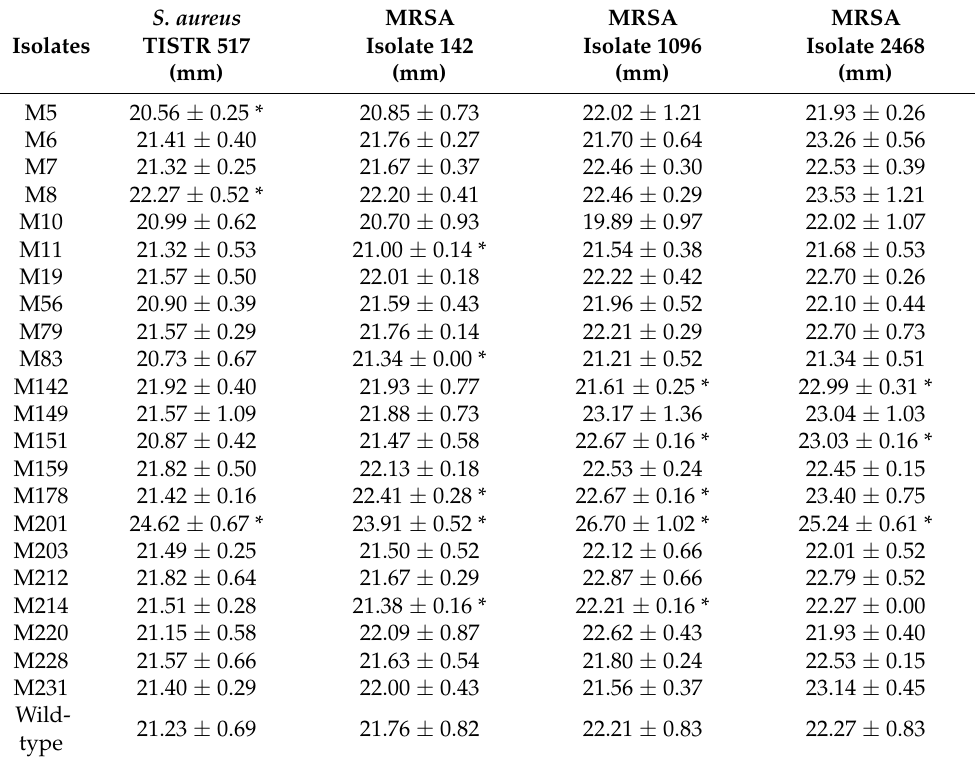
Table 4. Comparison of antibacterial activity between Brevibacillus sp. SPR-20 and its mutant strains by agar well diffusion (means ± SD; ( n = 3).